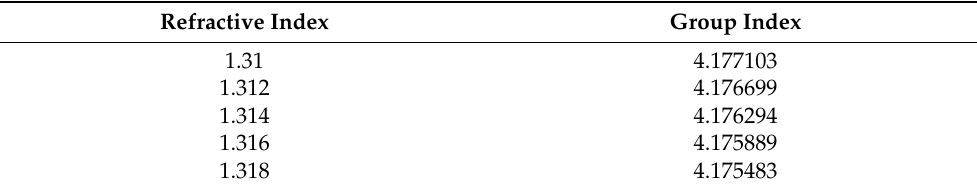
Figure 2 . Silicon wire waveguide structure . Figure 2. Silicon wire waveguide structure. Table 1. Silicon wire group index variation under various cladding refractive indices.